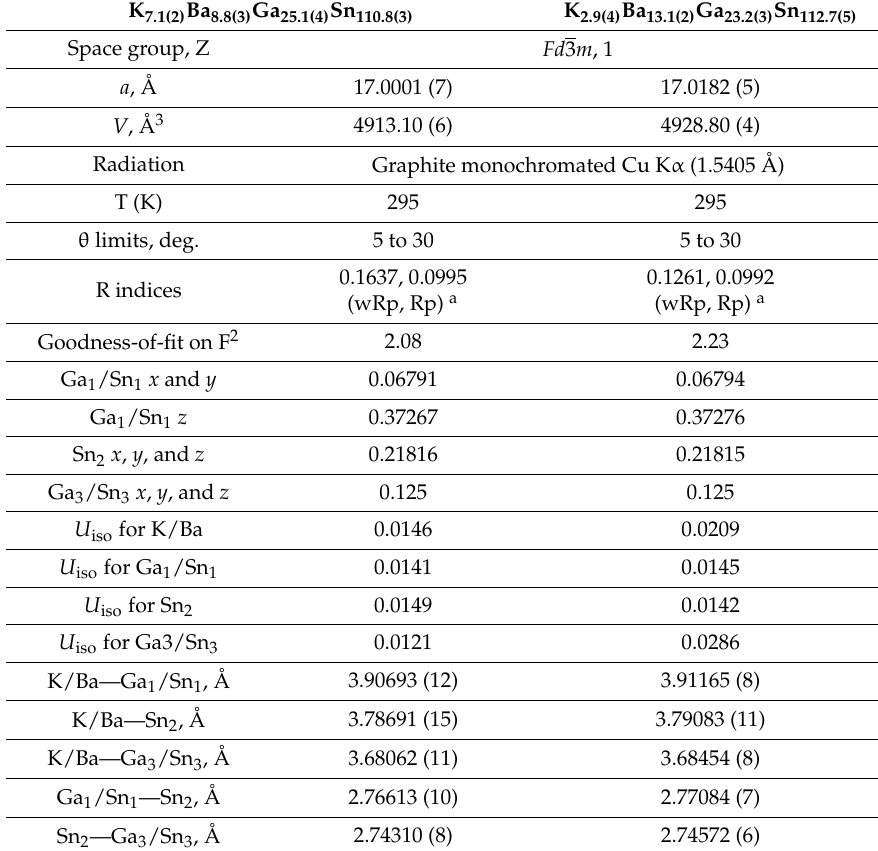
Table 1. Crystallographic details and selected bond distances for K 7.1(2) Ba 8.8(3) Ga 25.1(4) Sn 110.8(3)